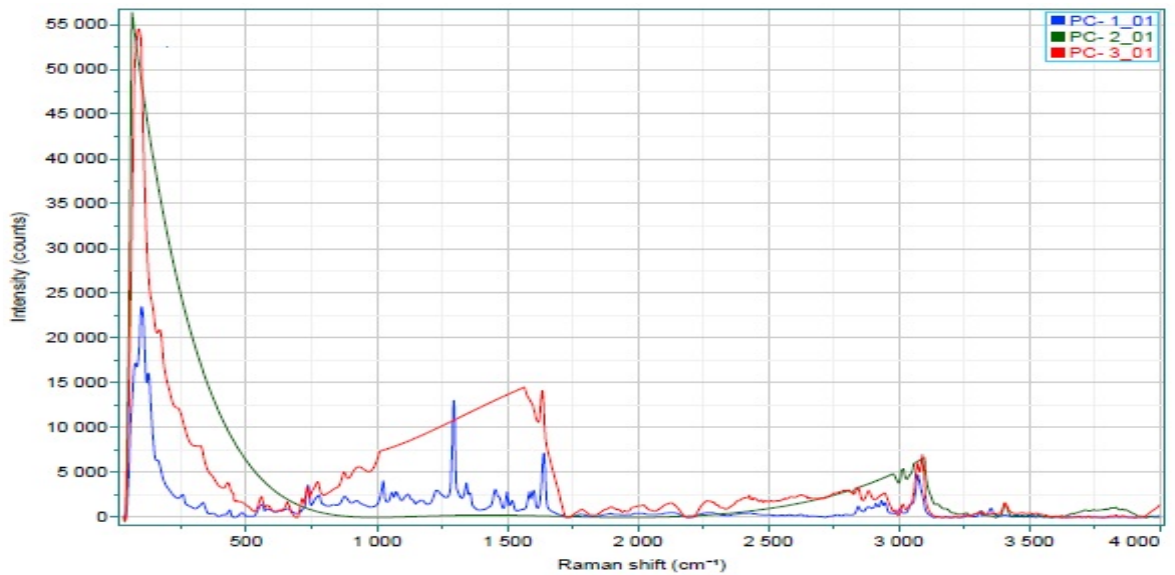
Figure 3. Raman spectroscopy analysis of CVL (Blue color), CVL-SDs (SDA/KM -Green color; SDC/ELV-Red color).